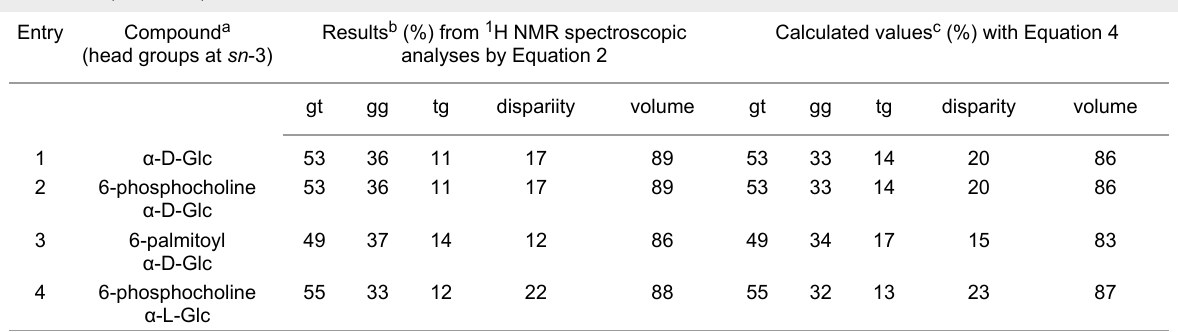
Table 4: Helical conformational properties of α -D- and α -L-glucopyranosyl 1,2-dipalmitoyl- sn -glycerols in the solvent mixture of CDCl 3 and methanol- d 4 (C/M = 10:1).